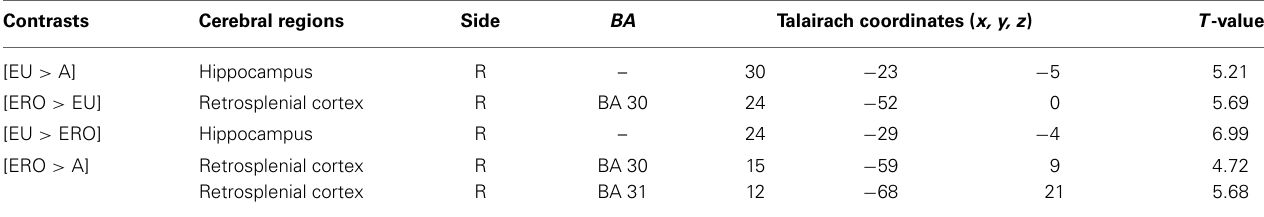
Table 6 | Hippocampal and retrosplenial activation in the FDR small-volume corrected analysis ( p < 0 . 05) of spatial encoding